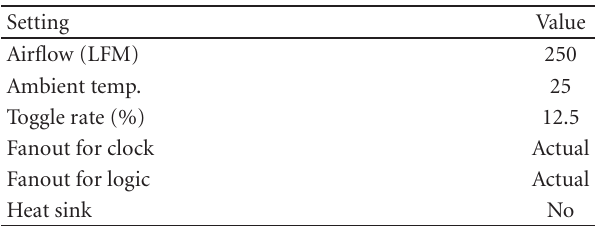
Table 11: Xilinx XPower analyzer settings.